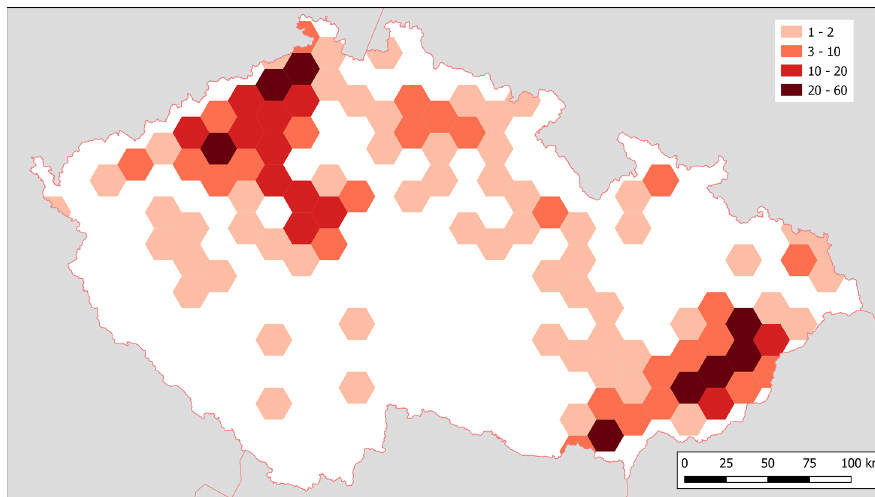
Figure 6. Landslide density across Czechia.